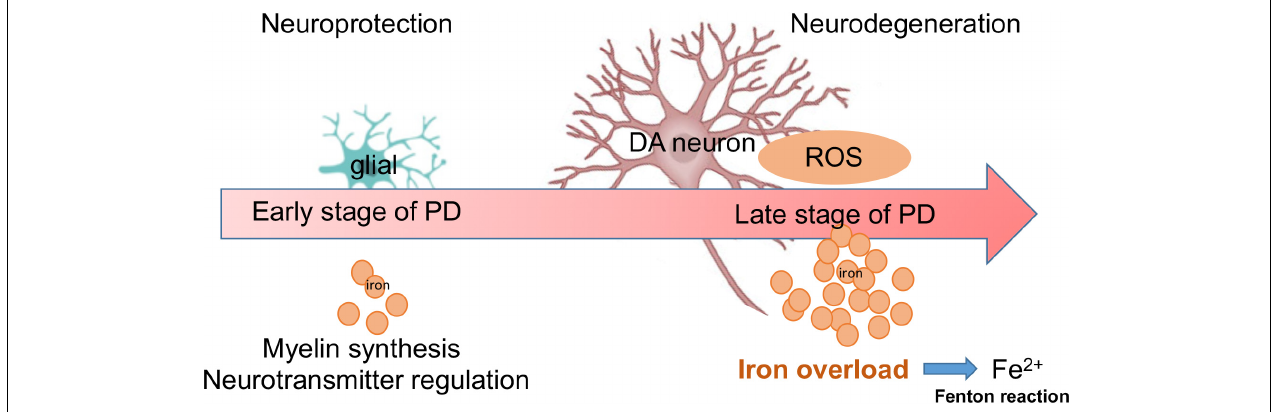
FIGURE 9 | A summary diagram is shown. Both glial and DA neurons are involved with iron metabolism in the progression of PD. During early stage of PD, low dose of iron may offer neuroprotection via myelin synthesis and neurotransmitter regulation. However, during later stages of PD, increased levels of iron may cause neurodegeneration through large amounts of ROS (Fenton